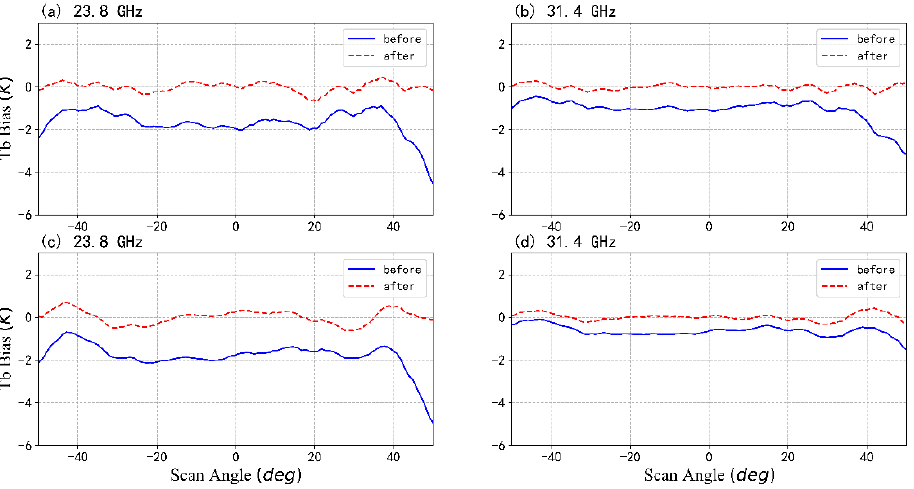
Figure 5. MWTS-III T b bias before and after correction for asymmetry of different channel frequencies at ( a , b ) ascending; ( c , d ) descending.